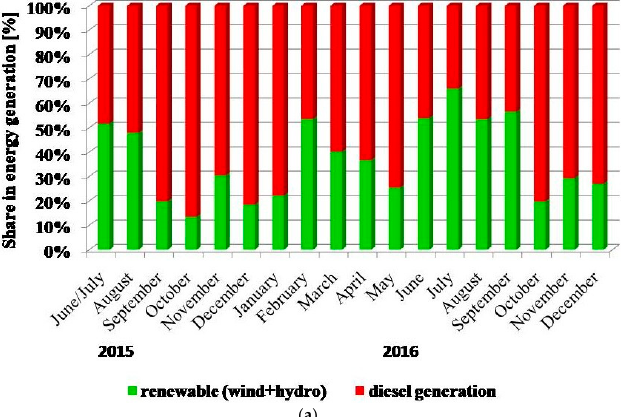
Figure 10. Operation of a hydroelectric plant in a windless period on 28–29 March 2018. Own study based on data from Red Eléctrica de España. Monitoring REE (Red Eléctrica de España) was carried out at 10 ‐ min intervals [58]. For the purpose of this work, the graphical relationship is shown in half ‐ hourly intervals. Signs: (1) water power, and (2) water in the bottom tank (required wind to be pumped into the upper